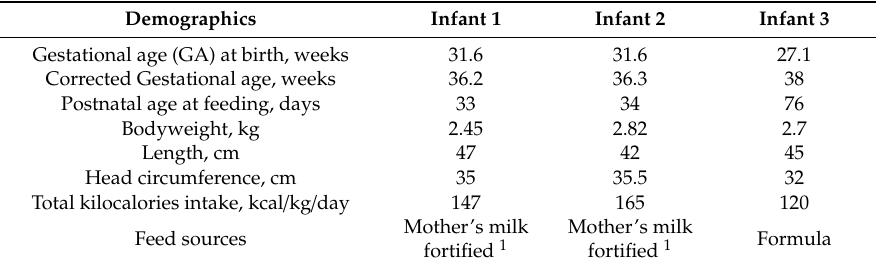
Table 1. Demographics of preterm-delivering mother–infant pairs sampled for mother’s own